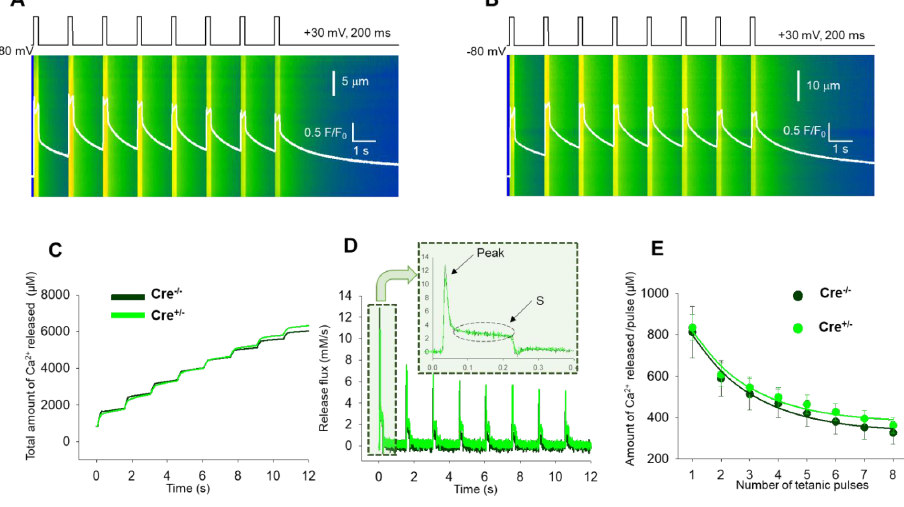
Figure 5. Unimpaired fatigability of Ca 2+ release in FDB fibers from Cre +/ − mice. Representative line-scan images illustrating the fatigability of the FDB fibers in Cre − / − ( A ) and Cre +/ − ( B ) fibers. The calcium transients were elicited by a train of depolarizing pulses to +30 mV with 1.5 s delay, lasting 200 ms each. The white trace is the temporal profile of the normalized fluorescence obtained by averaging 50 lines in the spatial domain normalized to average resting F 0 (x) values. ( C ) Evolution of the total amount of Ca 2+ released during the train of depolarization for the fibers in ( A , B ). ( D ) Evolution of the release flux calculated from the cytosolic Ca 2+ transients calculated for Cre − / − and Cre +/ − , respectively. Zoomed in view of the release flux illustrated for the first tetanic pulse of the series. The inset depicts two characteristic features of the release flux: the peak and the steady state (S). ( E ) The average amount of Ca 2+ released per pulse for 19 Cre − / − and 26 Cre +/ − fibers. A single exponential function was fitted to the points with the following parameters: y 0 = 326.95, a = 744.03, b = 0.46 for Cre − / − and y 0 = 374.01, a = 714.90, b = 0.48 for Cre +/ −